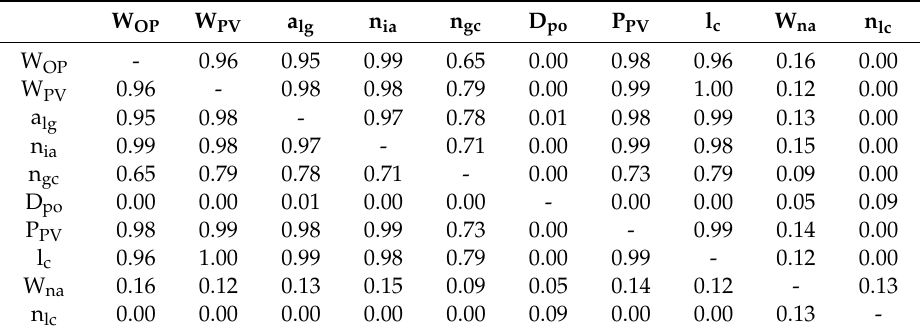
Table 4. Bravais-Pearson correlation matrix of all pairs of